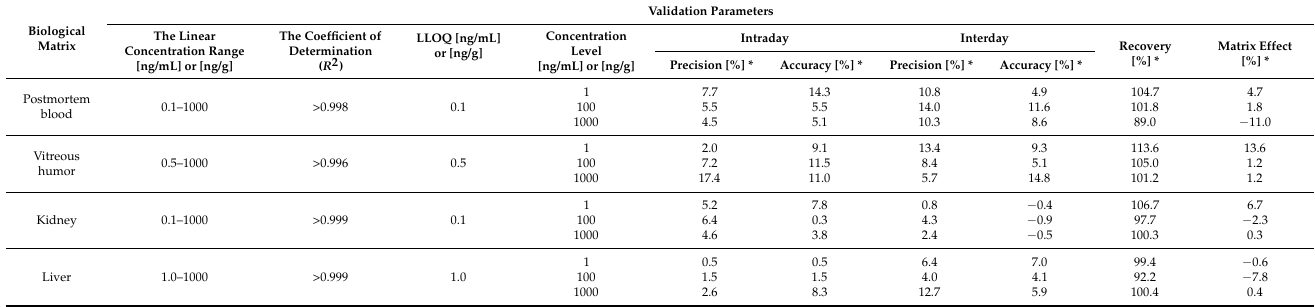
inal values, suggesting that there were no significant matrix effects for methotrexate. Table 2. Calibration curves parameters, LLOQ, recoveries, matrix effects, intra- and inter-day pre- cision and accuracy of the UHPLC-QqQ-MS/MS method for determination of methotrexate in postmortem fluids and